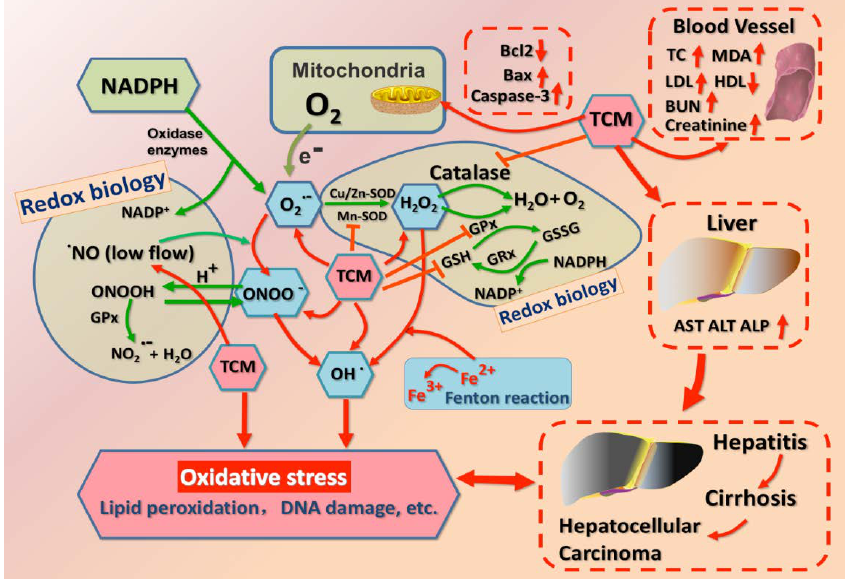
Figure 1. Schematic mechanisms of redox biology and traditional Chinese medicine (TCM)-induced oxidative stress in hepatocytes. oxidative stress in